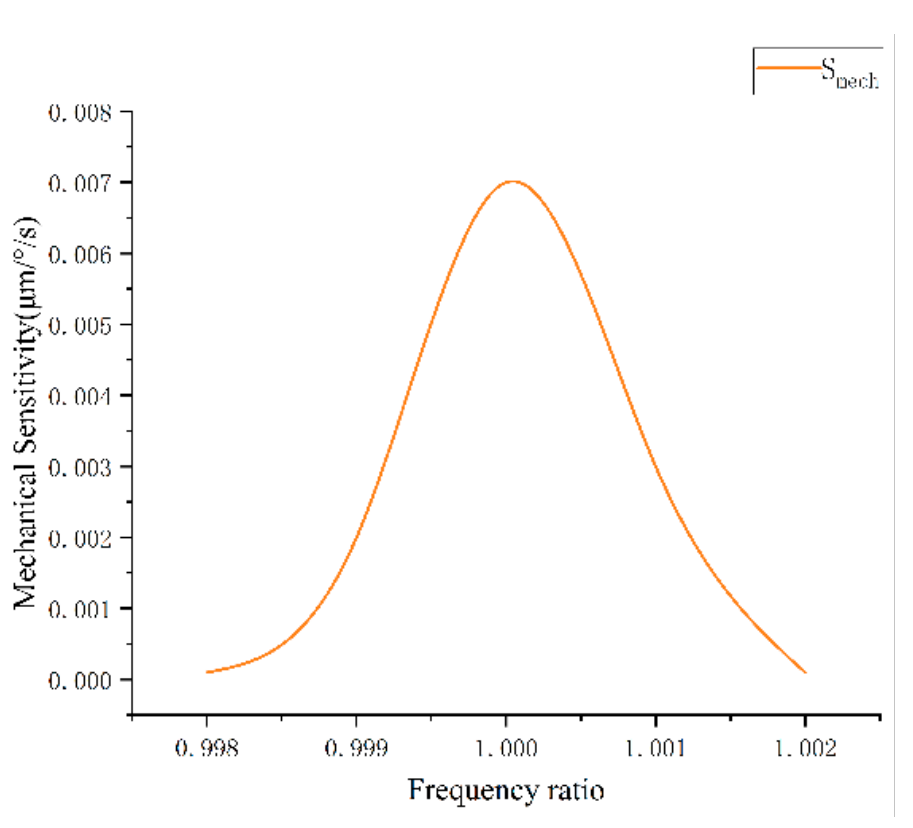
Figure 12. Variation of mechanical sensitivity with frequency ratio.